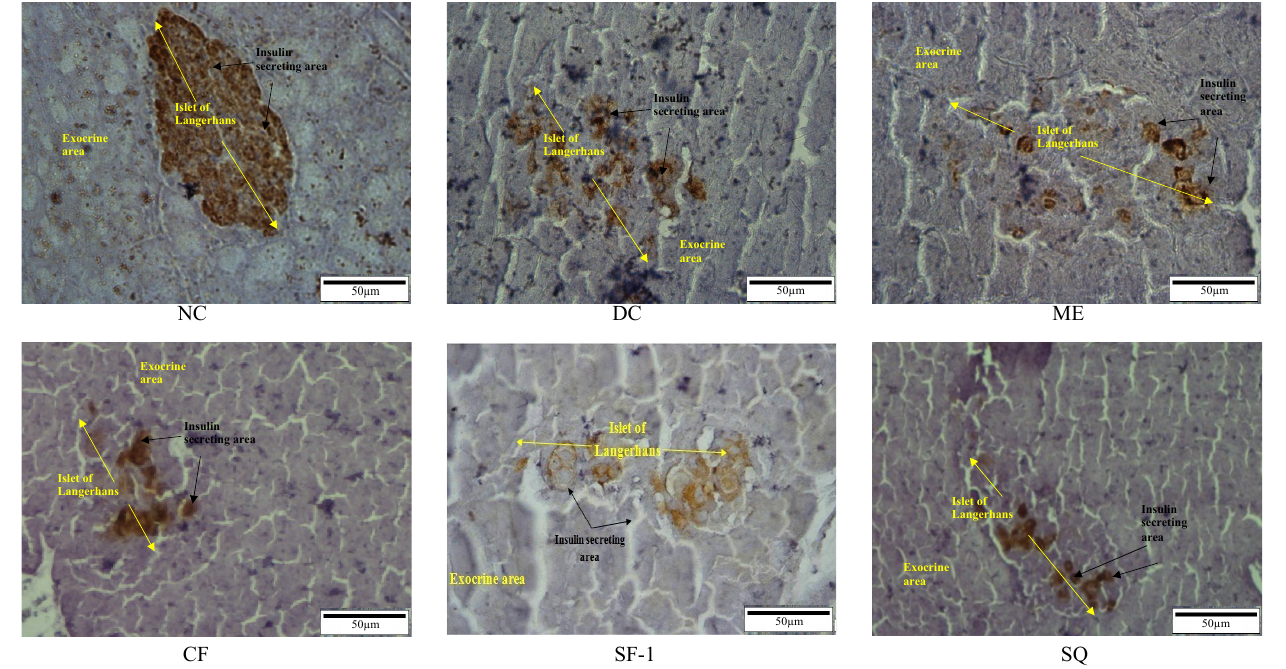
Figure 6. Immunohistochemistry staining of the β -cells pancreas after being treated for 12 days.